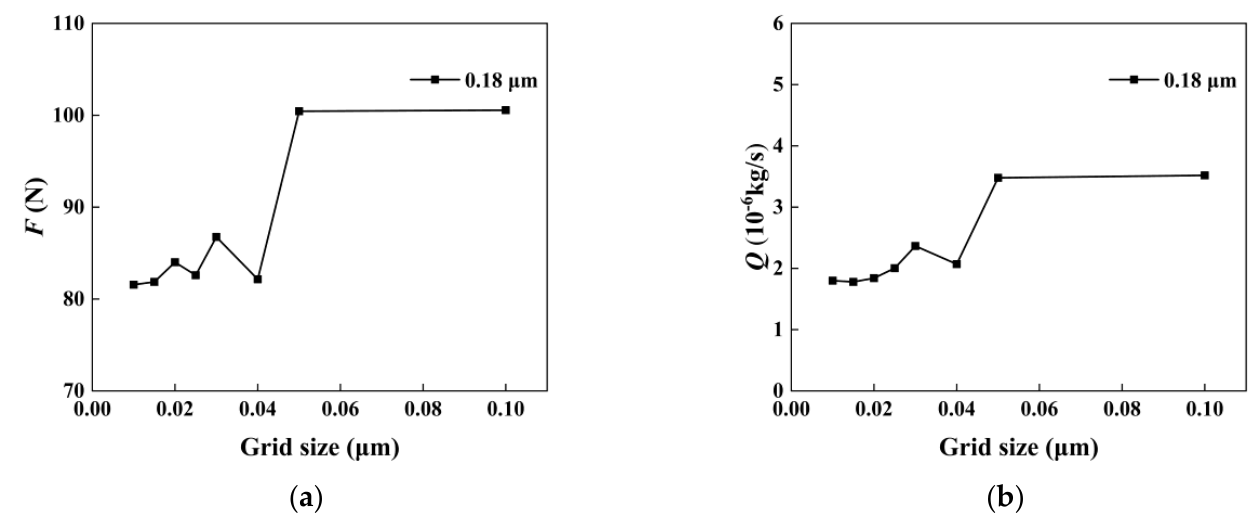
Figure 6. Changes in the sealing performance with the grid size considering the roughness of the non-grooved zone of the rotating ring: ( a ) Changes in the opening force, ( b ) changes in the leakage rate. In addition, for the surface of the stationary ring, a roughness standard deviation of σ 3 = 0.28 µ m was selected for independent grid verification. As Figure 7a,b shows, similar to the surface of the non-grooved zone of the rotating ring, when the grid size of the grooved zone was 0.025 mm, the changes in the opening force and the leakage with the grid size were minimal. Therefore, when the surface of the stationary surface was rough, the grid size of the selected surface was 0.025 mm.